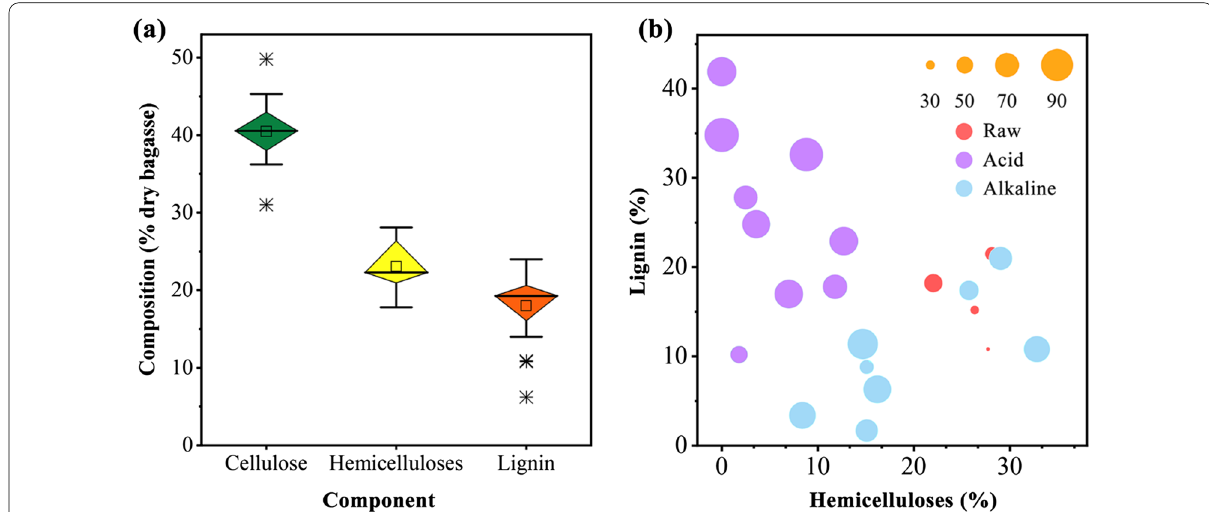
Fig. 7 Chemical composition and pretreatment effects of sweet sorghum bagasse. a Variations of components of dry bagasse [84, 93, 103–106, 121, 132, 141–152]. b Effects of acid/alkali pretreatments on the removals of hemicelluloses and lignin, and the ethanol yields of pretreated SSB